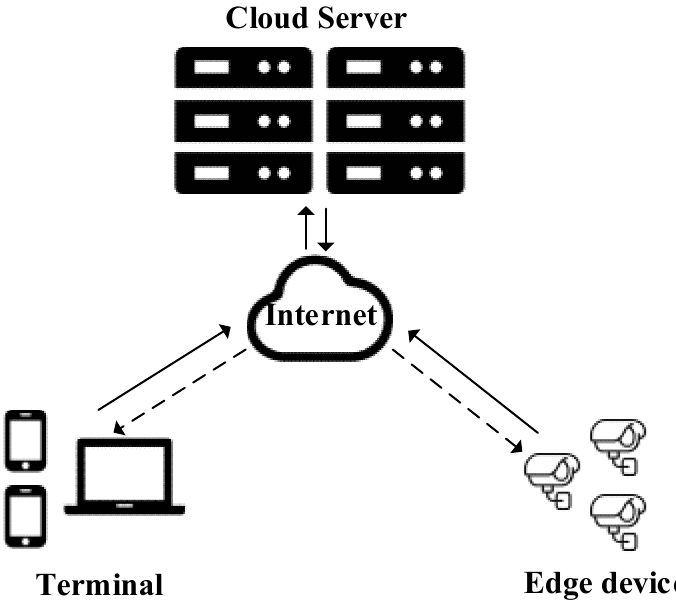
Figure 11. Traditional video stream analysis architecture based on cloud computing.